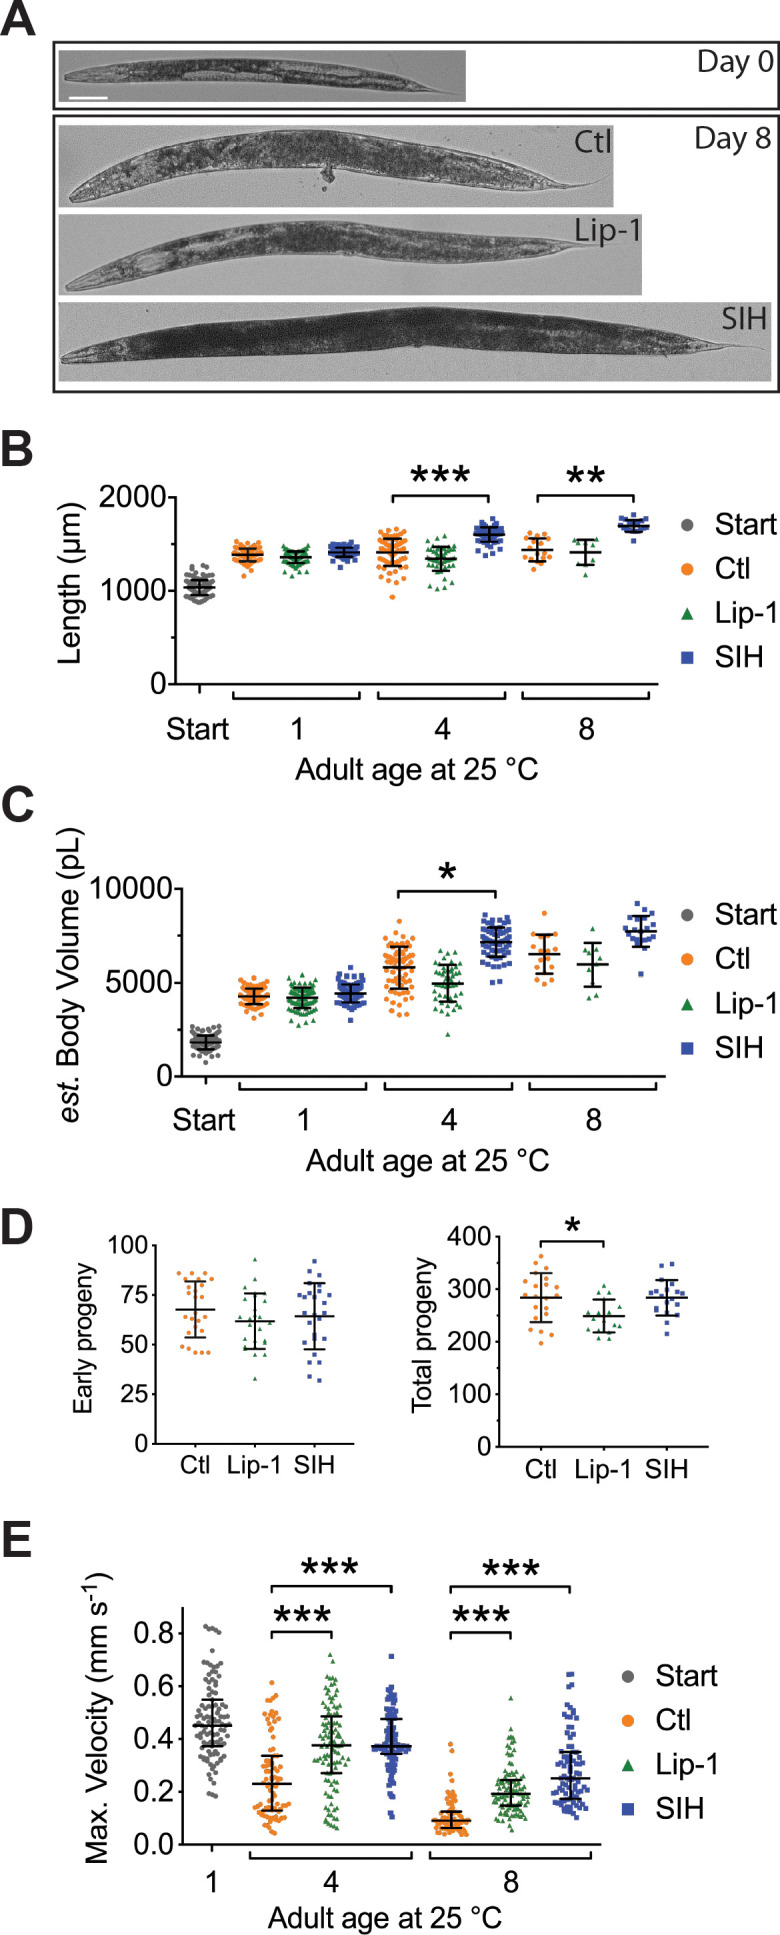
Lip-1 and SIH block frailty in C. elegans.In all panels, vehicle control (0.5% v/v DMSO, Ctl)-treated worms are shown in orange, Lip-1-treated (200 µM Lip-1) are green and SIH-treated (250 µM SIH) are blue.Significant differences between treatments are highlighted where * indicates p<0.05, ** indicates p<0.01 and *** indicates p<0.001. (A) Micrograph of an adult C. elegans on the first day of treatment (Day 0) and animals treated with Ctl, Lip-1 or SIH for eight days at 25°C (Day 8). Scale bar = 50 µm. (B) Estimates of adult body length (in µm), showing SIH- treated animals (blue) have longer average body length compared to age matched control (orange)or Lip-1 (green) treated populations (Kruskal-Wallis ANOVA: H(10) = 432.6, p<0.0001; see Supplementary file 6 for sample summary and pair-wise comparisons). Start (grey) represents the beginning population of L4/young adults grown from egg at 25°C for 48 hr prior to transfer to treatment plates. Each point represents an individual worm, with mean and error bars representing standard deviation (SD) (C) Estimated adult body volume (in pL), showing increased body volume with adult age for all groups (Kruskal-Wallis ANOVA: H(10) = 489, p<0.0001; see Supplementary file 6 for sample summary and pair-wise comparisons), with SIH treated animals having even greater body volume. Each point represents an individual worm, with mean ± SD. (D) Early fertility (first 24 hr) and total reproductive output are unaltered when vehicle control (Ctl)-treated cohorts are compared to Lip-1 or SIH-treated animals at 25°C. Each data point represents an estimate from a single C. elegans adult, with mean ± SD. Sample size: early fertility Ctl n = 25, Lip-1 n = 26, SIH n = 26; total Ctl n = 21, Lip-1 n = 17, SIH n = 19 (ANOVA: Early fertility F(2,74)=0.996, p=0.37; Total fertility F(2,57) = 4.89, p=0.011). (E) Estimates of maximum velocity achieved by aged and treated cohorts of C. elegans. Treatment with either Lip-1 or SIH attenuates the age-related decline in maximum velocity (Kruskal-Wallis ANOVA: H(7) = 298.5, p<0.0001; see Supplementary file 6 for sample summary and pair-wise comparisons). Each data point represents an estimate from a single C. elegans adult, with median ±interquartile range. Equivalent analyses of mean velocity and total distance travelled (and how these data correlate) are shown in Figure 6—figure supplement 1 and Supplementary file 6).Figure 6—source data 1.Data for fertility, size and movement.